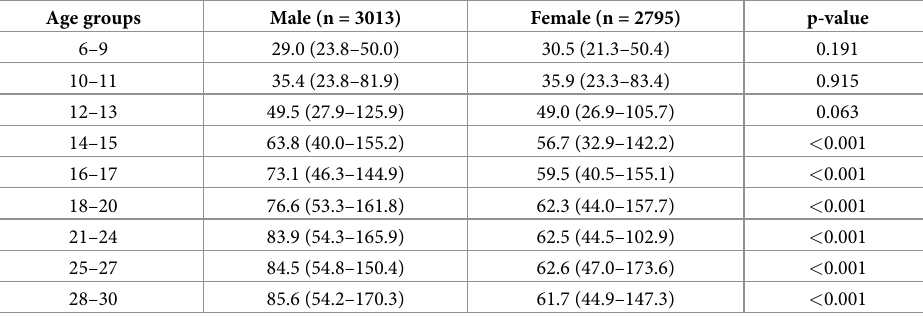
Table 2. Median (range) of body mass in kilograms for each age interval.